Question: What type of chart is this?
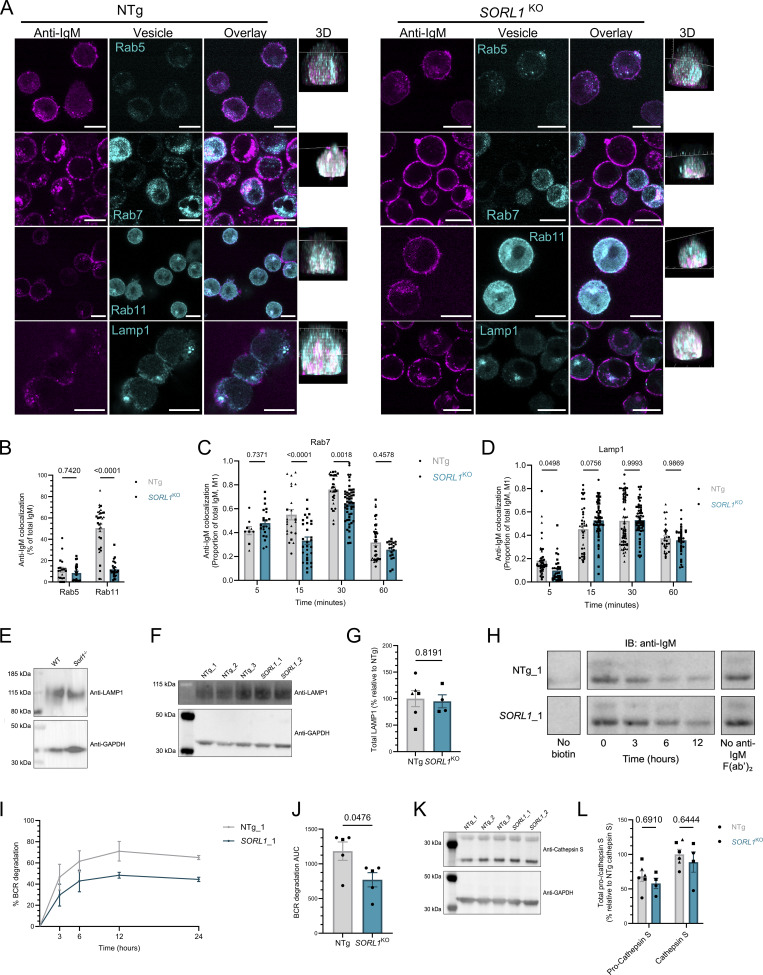
Answer: bar